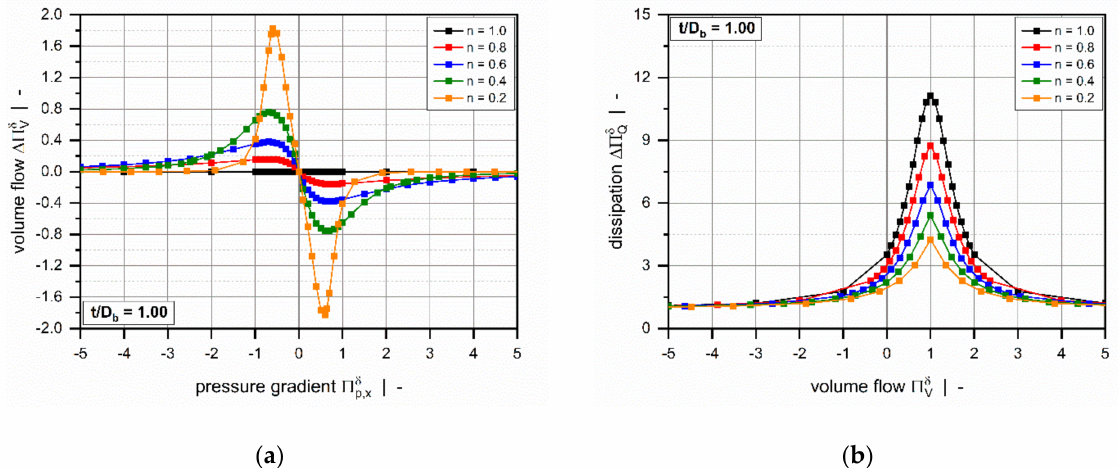
( a ) and corrected dimensionless dissipation ∆ Π δ V for a square-pitched screw with t / D b = 1.0 and a polymer melt with V